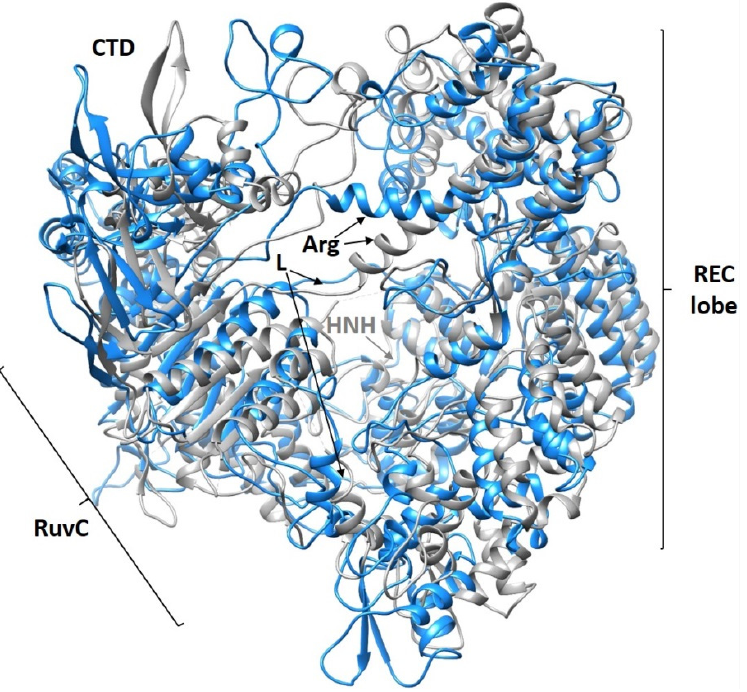
Figure 4. Comparison of the most represented Cas9 cluster (blue) with the structure obtained by X-ray crystallography PDB ID: 4OO8 (gray). Table 2. Values of complex formation energies obtained with MM-GBSA and